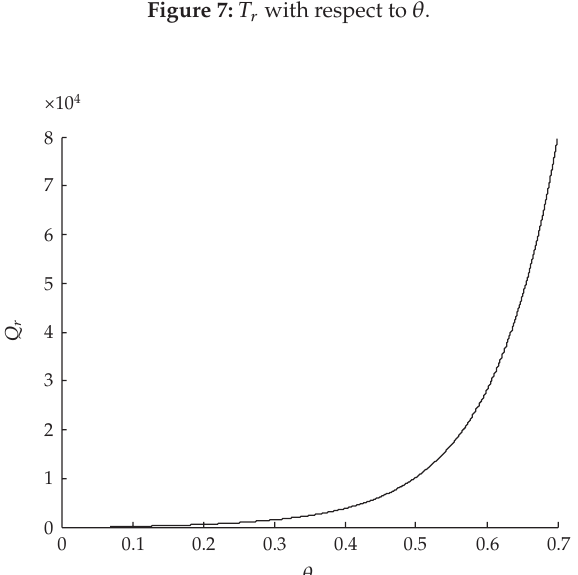
Figure 7: T r with respect to θ .